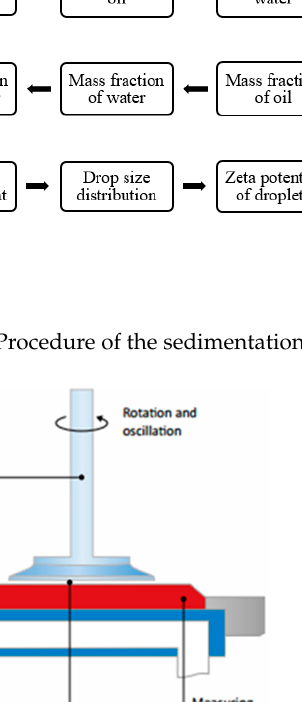
Figure 4. Parallel-plate measuring system in the rotational and oscillatory rheometer.